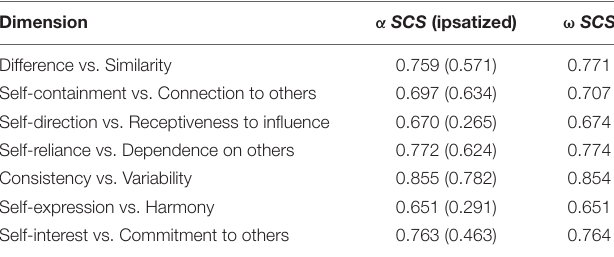
TABLE 5 | Reliability estimations of the Czech version of the SCS